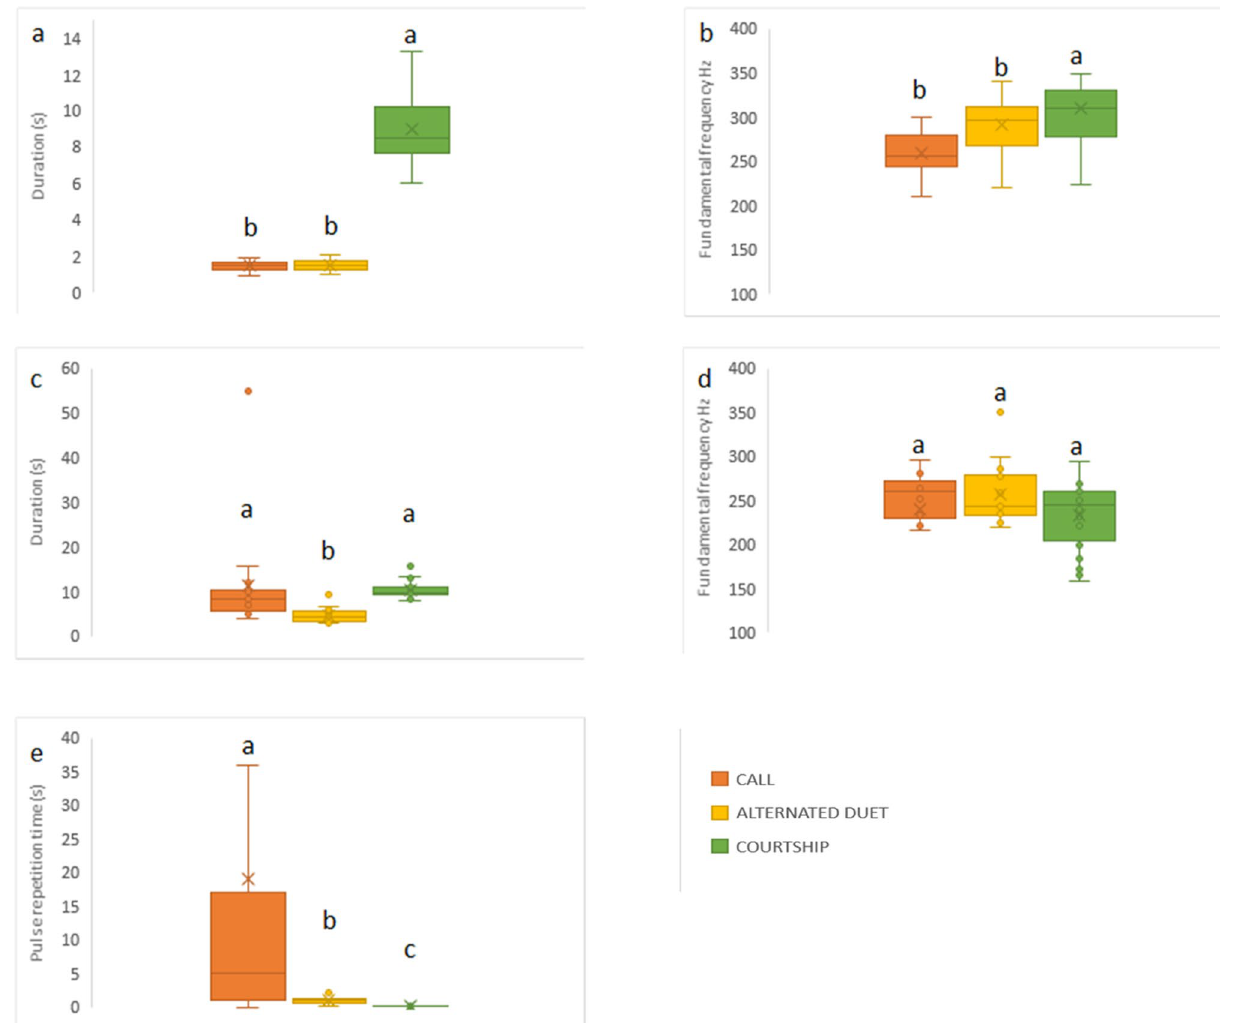
Figure 2. Boxplots of spectral and temporal parameters of GW vibrational signals across three different mating stages (exp. 4, pairs). In orange “call”, in yellow “alternated duet”, in green “courtship”. ( a ) chirp duration, ( b ) chirp fundamental frequency, ( c ) PT duration, ( d ) PT fundamental frequency, ( e ) pulse repetition time. Significant letters indicate significant differences among signals after Kruskal–Wallis test followed by Mann– Whitney pairwise test ( P <